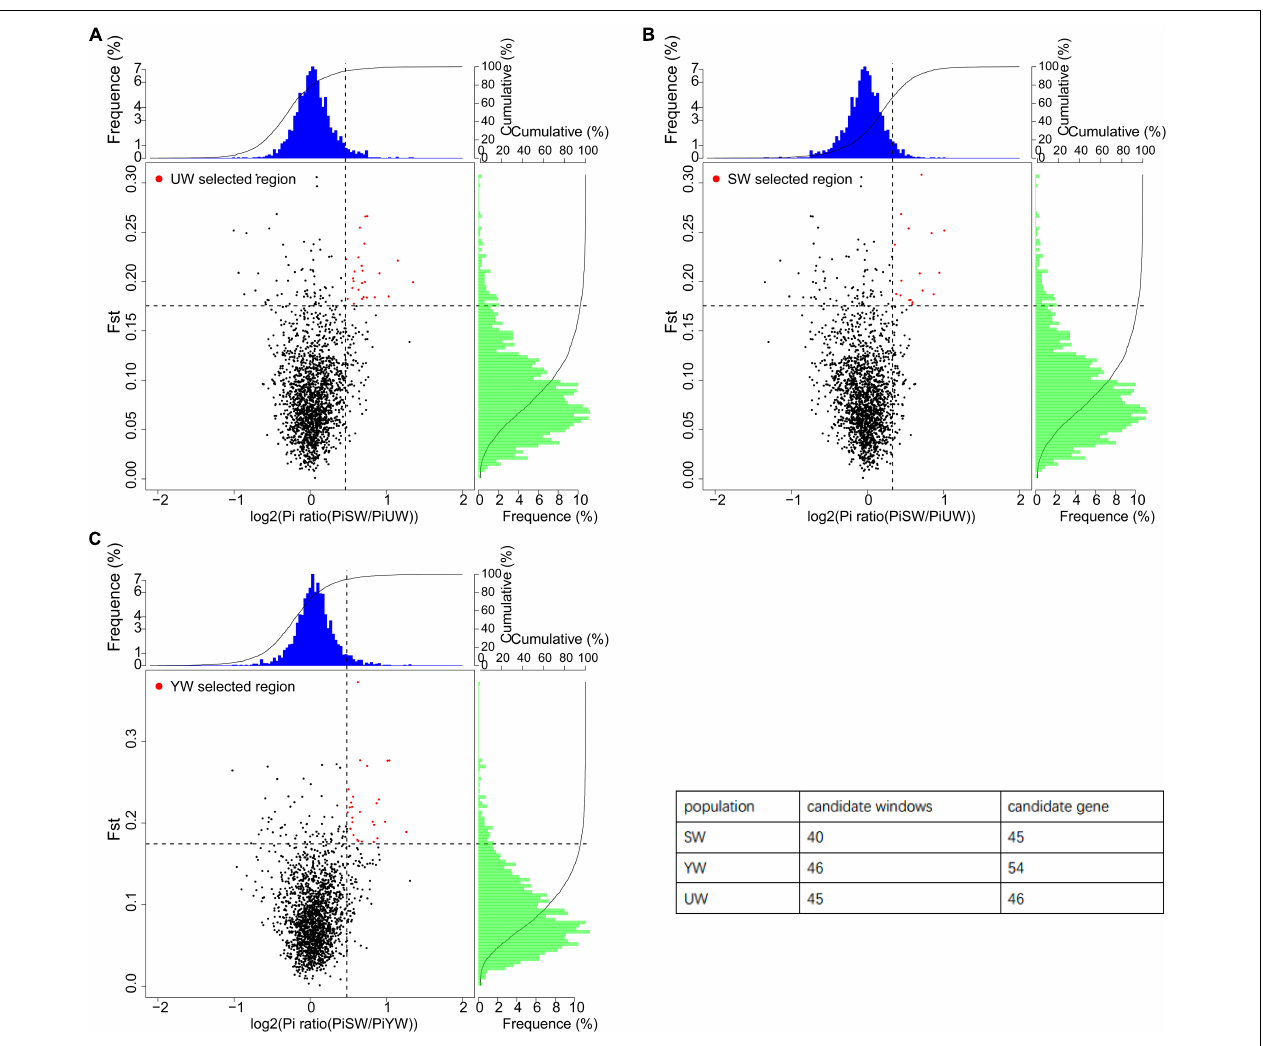
FIGURE 5 | Selective sweep analysis of different G. uralensis populations. The abscissa is the θπ ratio value, which corresponds to the frequency distribution at the top of the figure. The ordinate is the Fst value, which corresponds to the frequency distribution on the right side of the figure. The points in the middle of the figure represent the corresponding values of Fst and θπ ratio in different Windows. The blue and green regions are the top 5% regions selected by θπ , and the red regions are the top 5% regions selected by Fst. (A–C) Represents G. uralensis of eastern, central and southern regions,